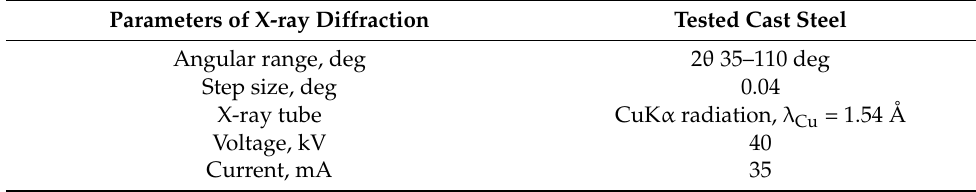
Table 2. Parameters of X-ray diffraction.